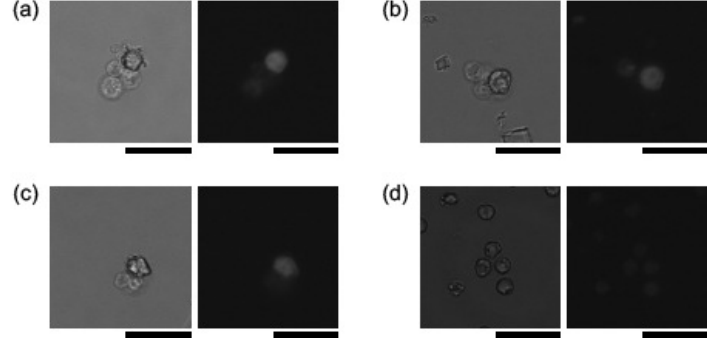
Figure 14. Three typical cell cluster images in positive cases ( a – c ) and a cell image in control 1 ( d ). Left, BF, and right, FL images. All FL images were taken with the same camera conditions. Bars, 50 µ